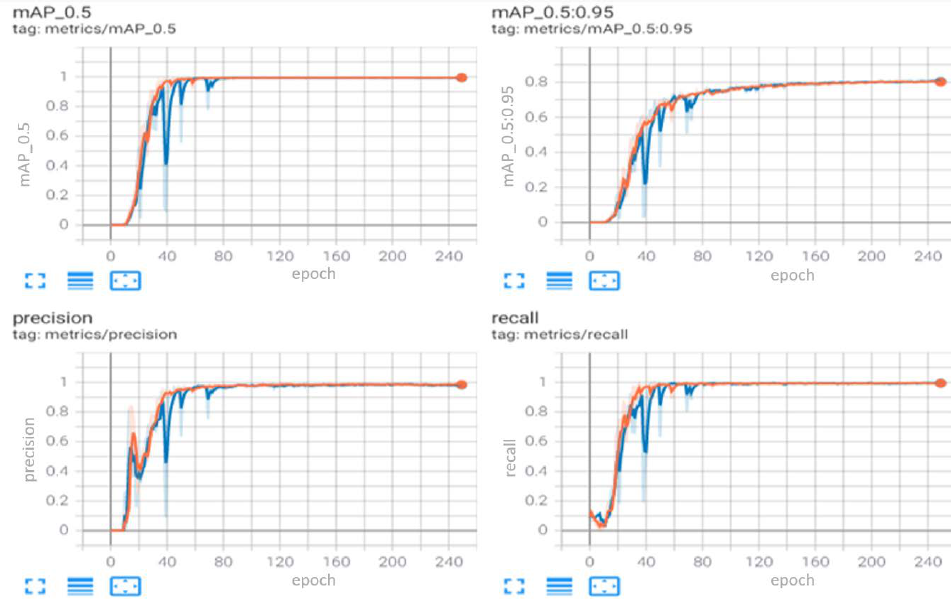
Figure 5. Comparison of performance metrics, during training, for YOLOv5s and YOLOv5m. The performance of YOLOv5s is shown in blue and YOLOv5m is shown in orange.